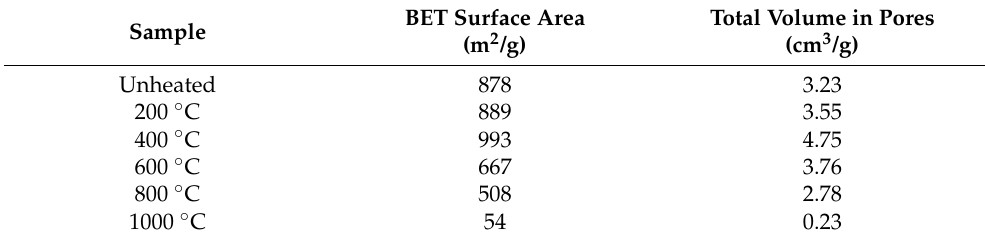
Table 2. BET surface area and pores volume of the silica aerogel samples.